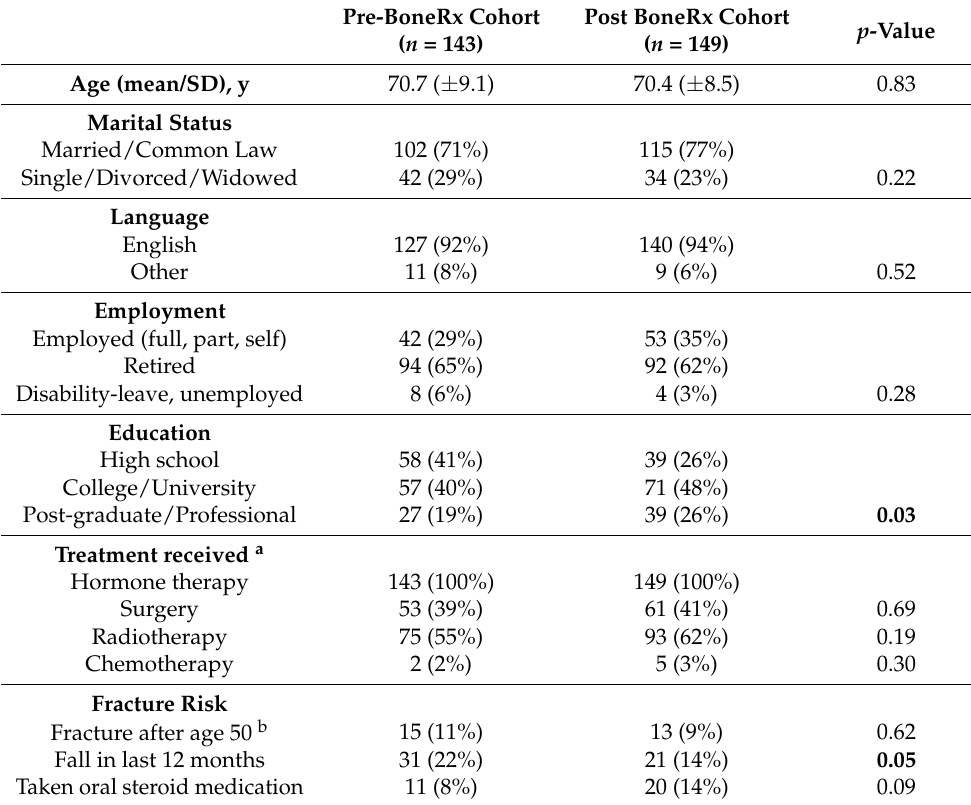
Table 1. Demographic and clinical variables of study